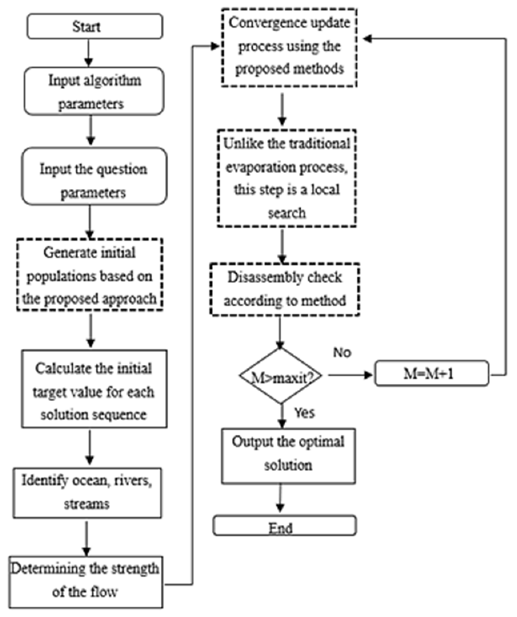
Figure 6. WCA algorithm flow chart.